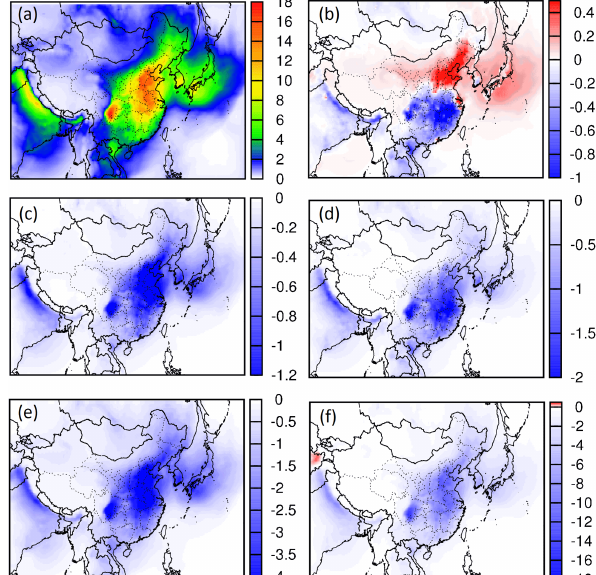
Figure 10. Same as Fig. 8, but for January